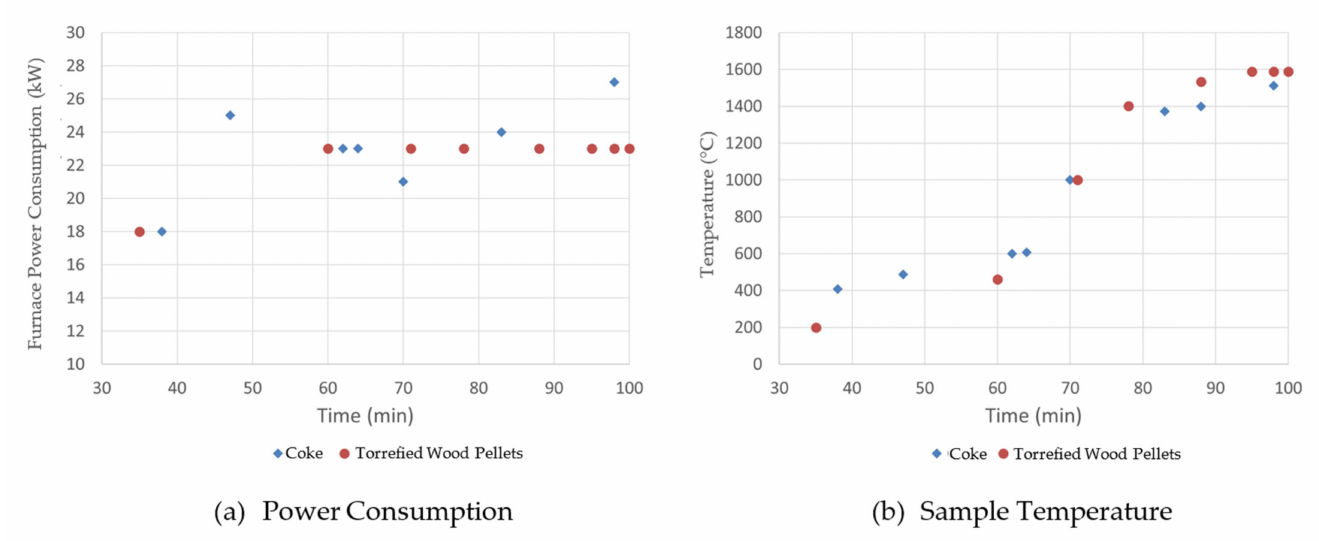
Figure 3. Effect of torrefied wood pellets on steel melting power